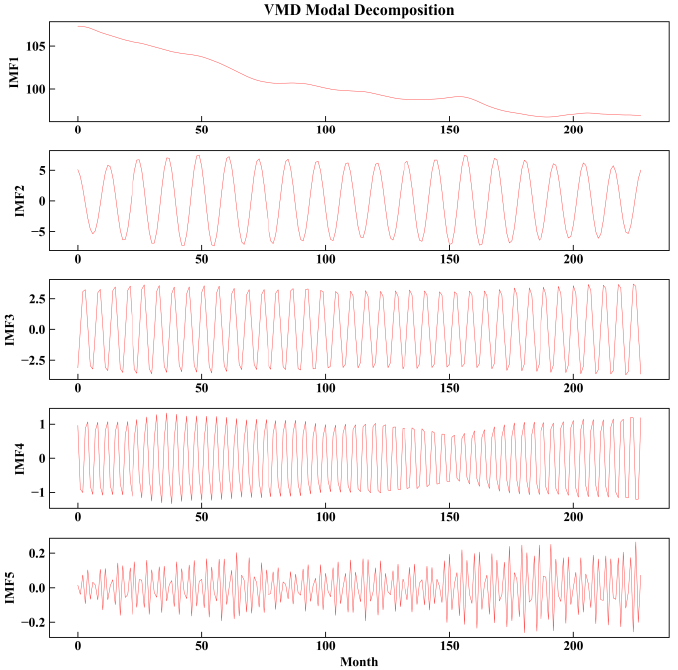
Figure 16. Decomposition diagram of CO concentration based on VMD